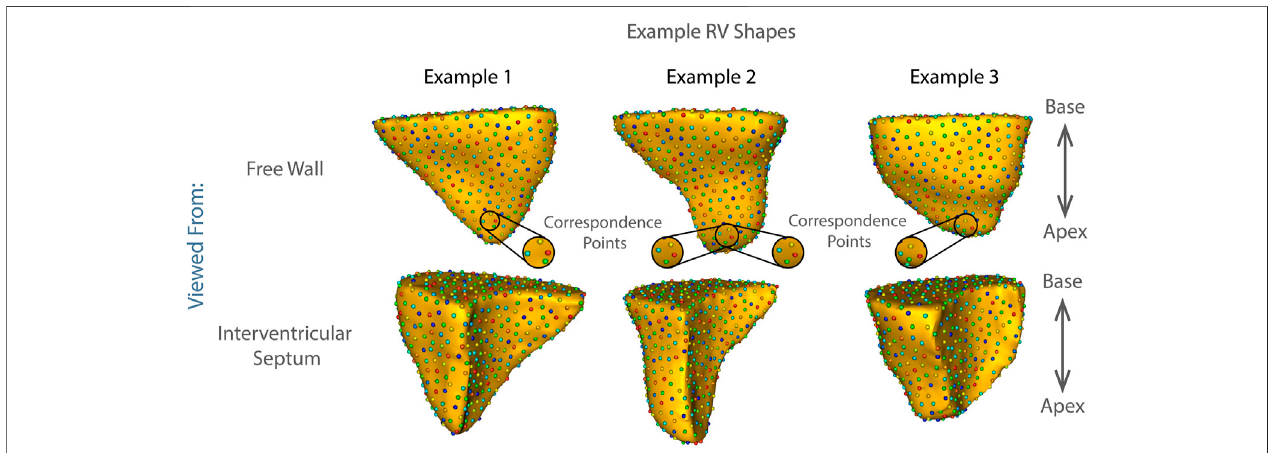
FIGURE1| ExamplesofshapecorrespondencemodelsofrightventricularshapeobtainedusingShapeWorks.ThecoloredspheresonthesurfaceofeachRVare theoptimizedcorrespondencepoints/correspondinglandmarksthatfullyparameterizetherightventricularshapebasedonthepopulationdata(seeMethods:Statistical Shape Model Construction). The three examples showcase the complexity of the RV shapes in the cohort.